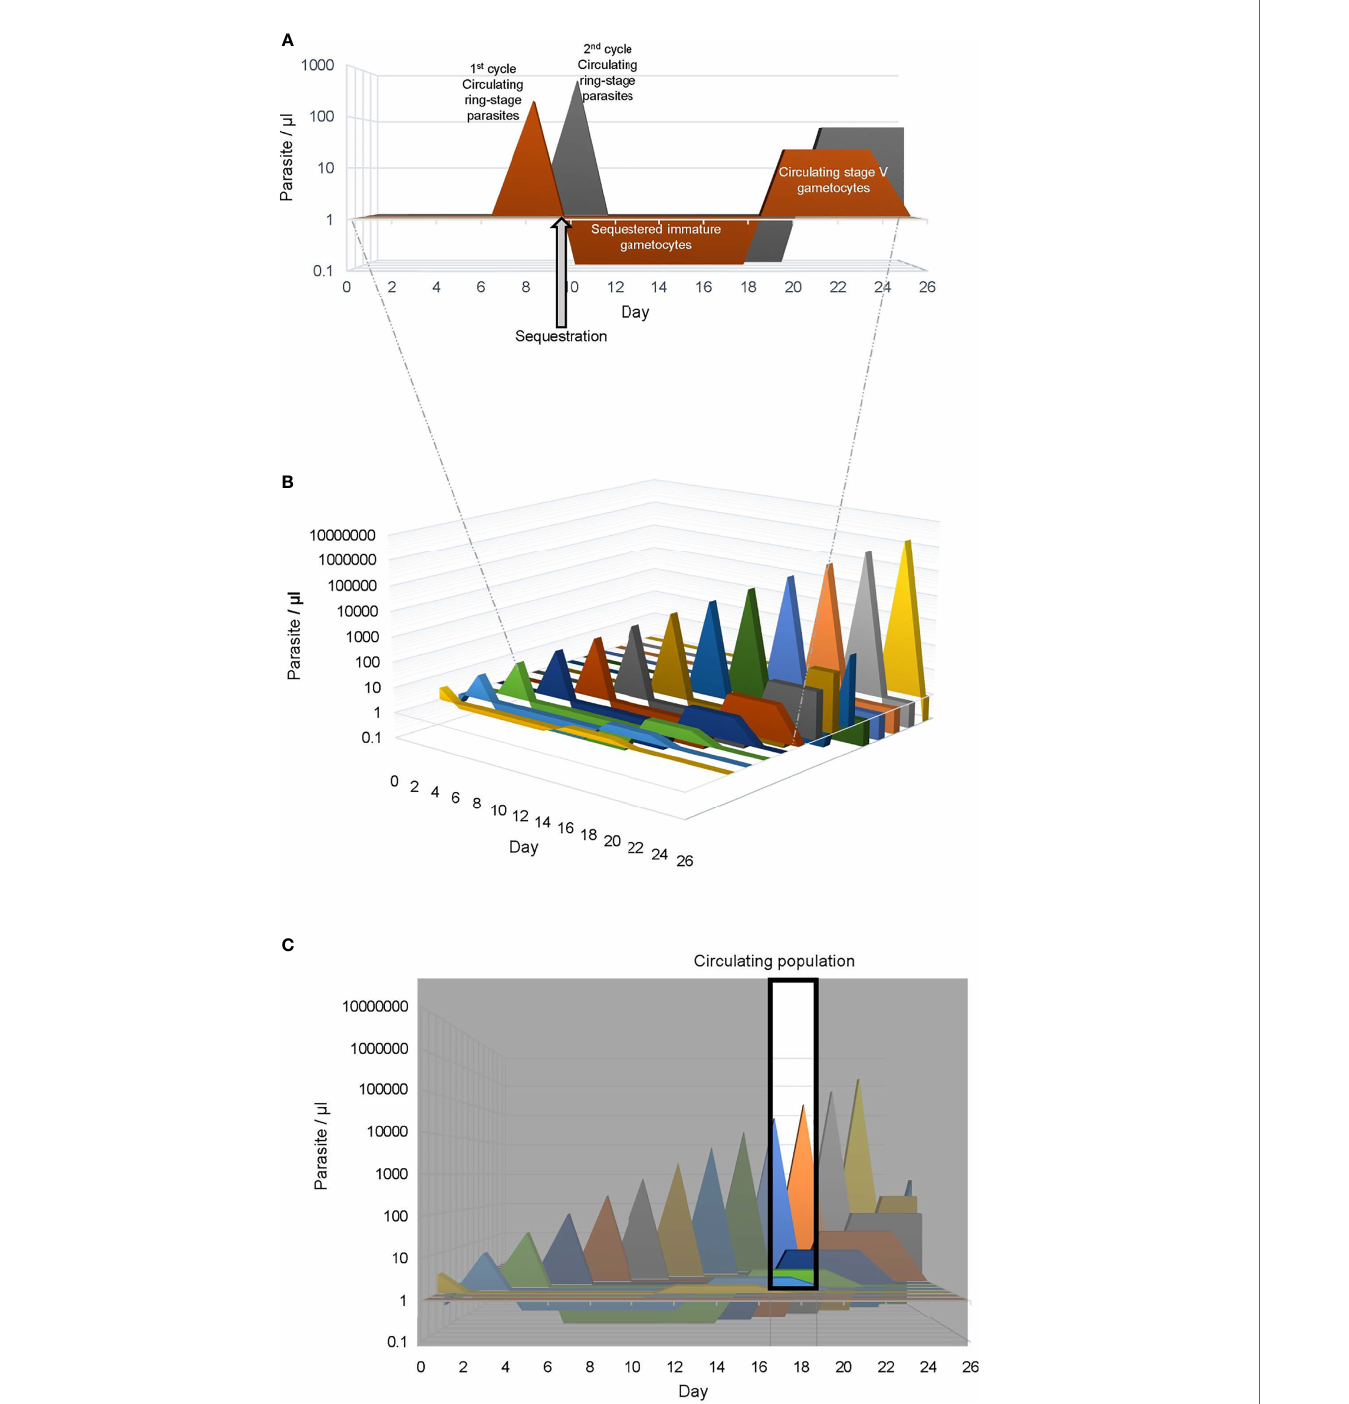
FIGURE 2 | Human Plasmodium falciparum infection dynamics. Graphical representation of P. falciparum infection dynamics in human peripheral blood assuming a multiplication rate of three and a 10% sexual commitment rate. (A) The asexual ring stage and sexual stage parasites produced from 2 consecutive life cycles (1st, orange and 2nd, gray) is shown. The parasitemia of the circulating ring-stage and mature stage-V gametocytes is indicated as a positive value on the vertical axis, while the sequestered immature gametocyte parasitemia is indicated as a negative value. For clarity the sequestered mature asexual parasitemia is not included. (B) The graph is expanded to depict the asexual and sexual parasites produced in 13 sequential life cycles, mimicking a 26 day P. falciparum blood stage infection. (C) The window indicates the population of parasites collected in a blood sample obtained between day 17 and 19, which would include circulating ring stage parasites < 30 hours post RBC invasion from the 10th and 11th life cycles and mature stage V gametocytes (>10 days post RBC invasion) from the fi rst 4 life